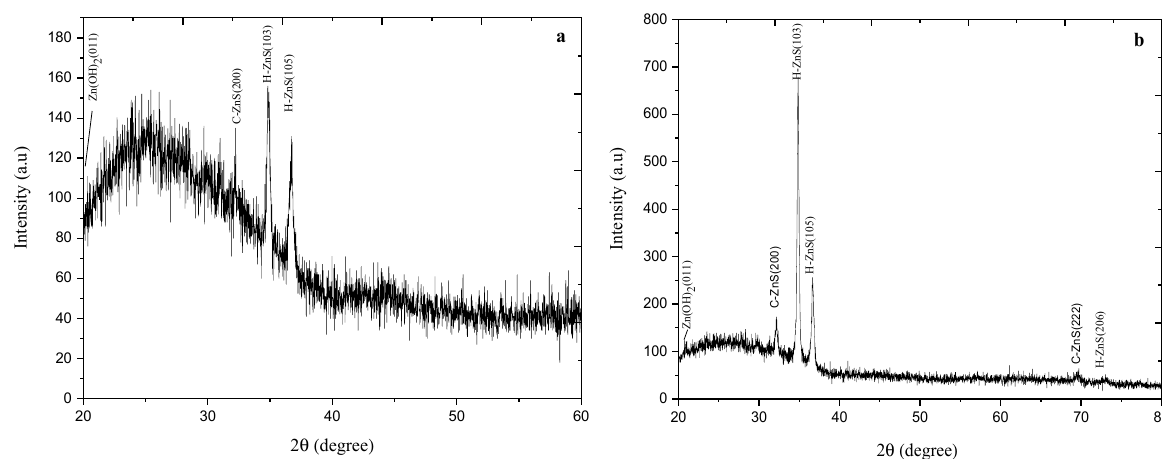
Figure 2. XRD pattern for as-deposited ZnS thin films ( a ), and ( b ) annealed ZnS thin films at 300 °C for one hour.